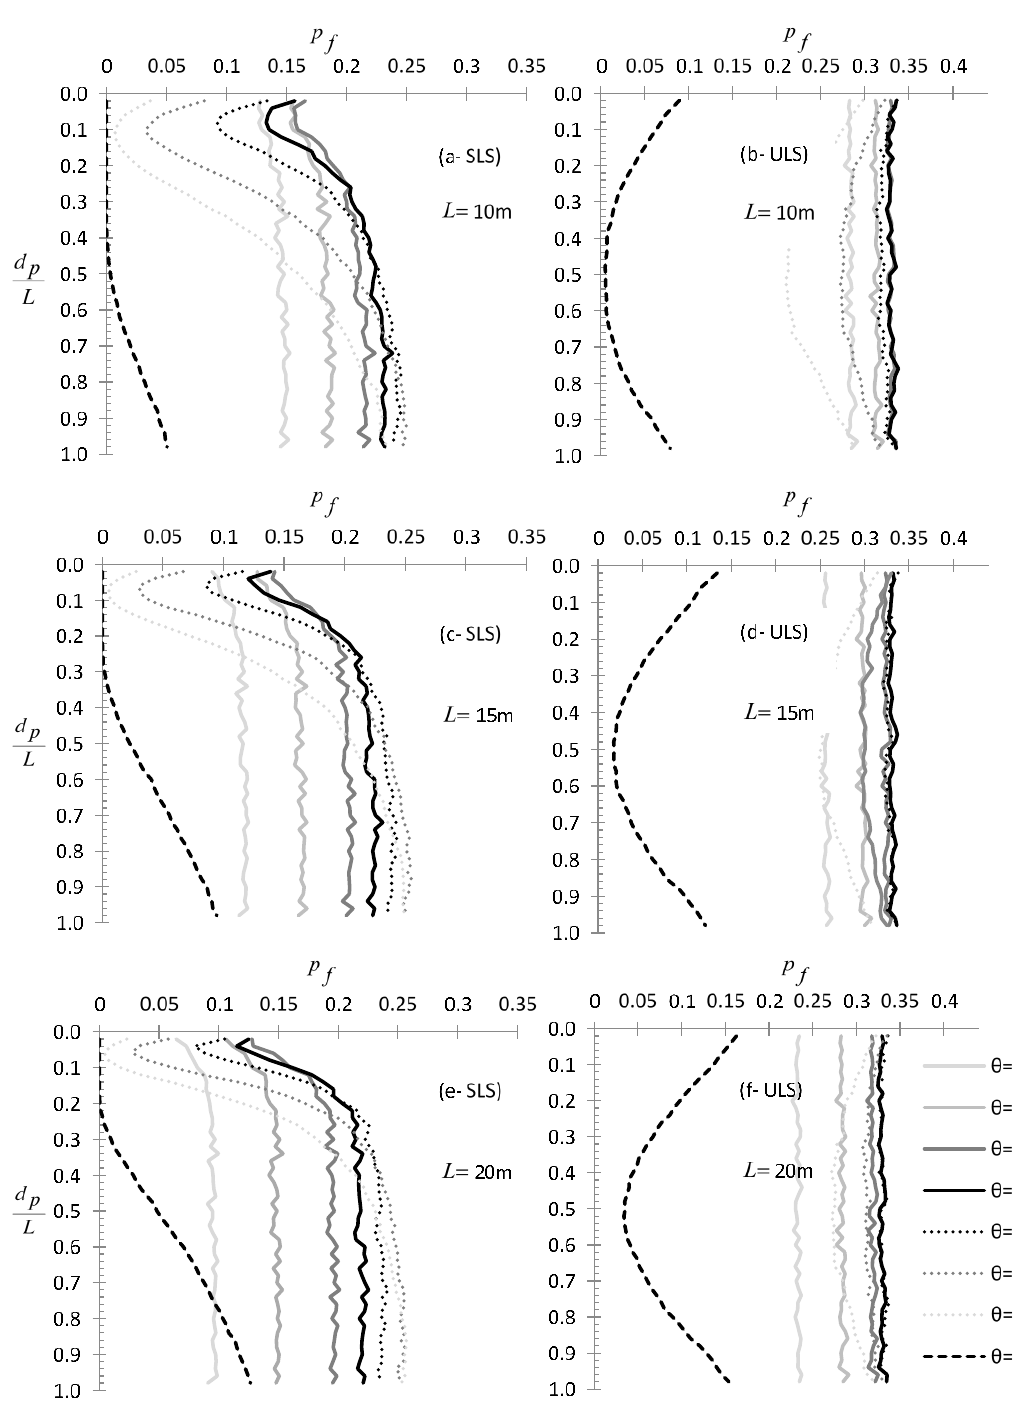
Figure 2. f p vs. d p / L curves for various θ values and for three di ff erent pile lengths. Figures ( a ), ( c ), and ( e ) refer to SLS state for L = 10, 15 and 20 m respectively and figures ( b ), ( d ), and ( f ) to the ULS state also for L = 10, 15 and 20 m respectively.